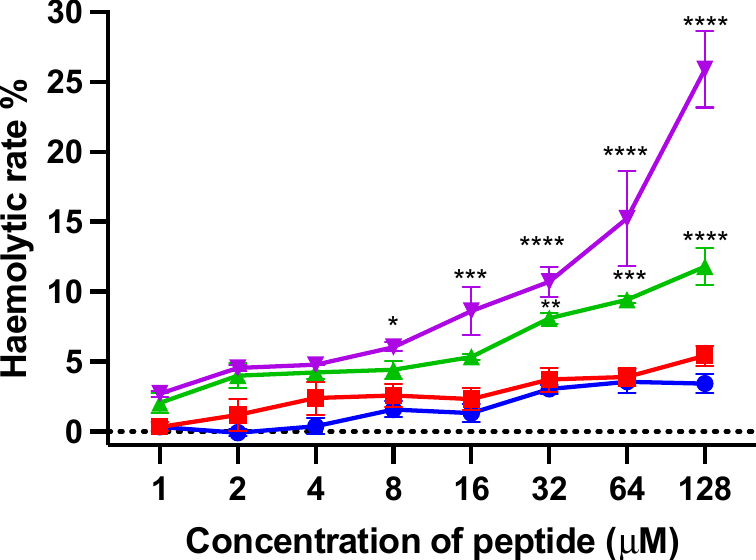
Figure 8. The haemolytic activity of kunitzin-OV 2 (blue), F9-KOV 2 (red), TAT-KOV 2 (green), and TAT-F9-KOV 2 (purple) at concentrations from 1 to 128 µM. Horse erythrocytes (2% in PBS) treated with 0.1% Triton X-100 and PBS were used as the positive and negative controls, respectively. The error bar represents the SEM of nine replications in three experiments and the significant differences were calculated by comparing various treatments with the negative control (* p < 0.05, ** p < 0.01, *** p < 0.001, and **** p < 0.0001).